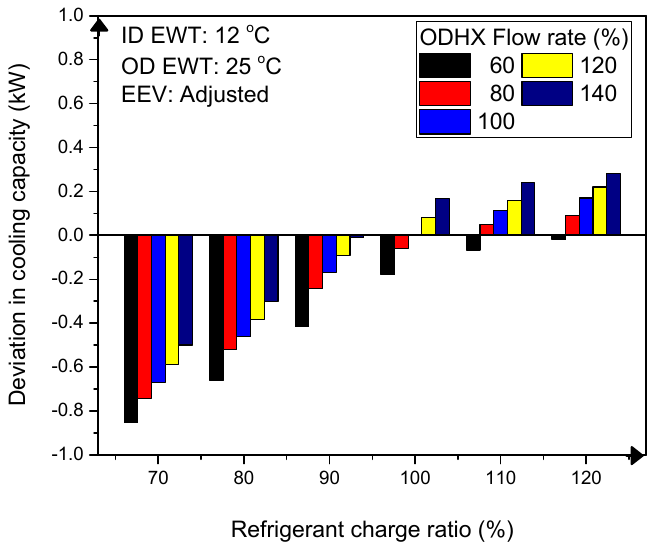
Figure 5. Change in capacity according to refrigerant charge and outdoor heat exchanger flow rate combined faults.